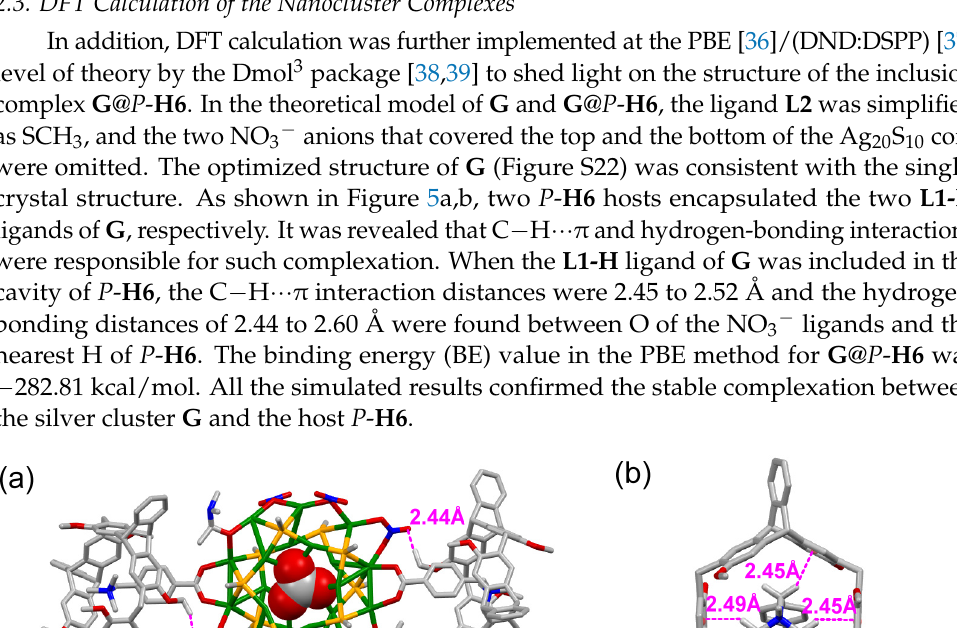
Figure 4. TEM images of ( a ) the silver cluster G (inset: DLS image of G ) and ( b ) the nanocluster complex G @ P - H6 (inset: DLS image of G @ P - H6 ).